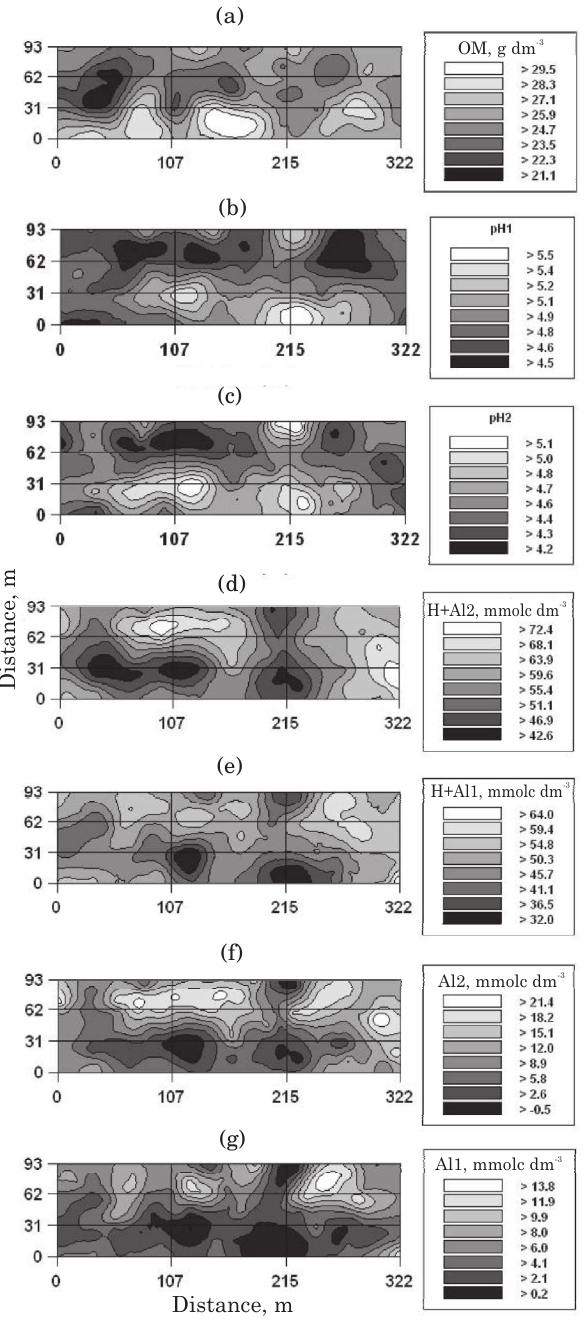
Figure 2. Kriging maps of the chemical properties of a Typic Acrustoxunder